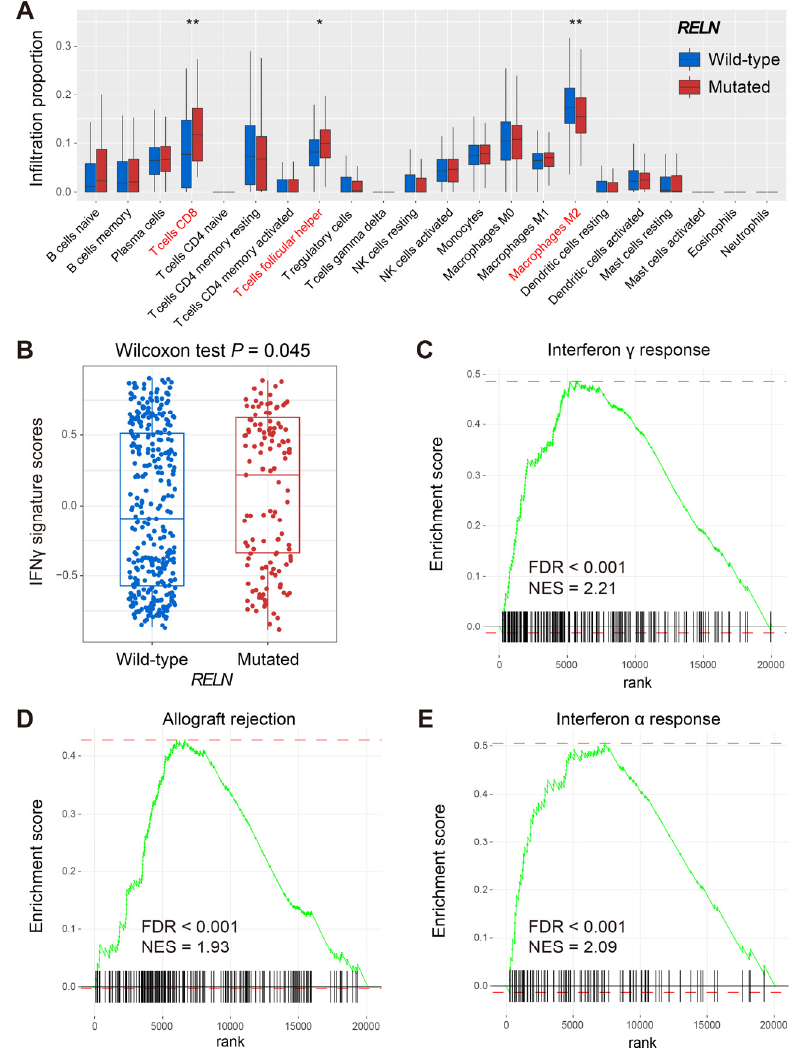
Figure 5. Immune infiltration and signaling pathways behind RELN mutations in melanoma. ( A ) CIBERSORT method revealed the distinct immunocyte infiltration in RELN two subgroups. ( B ) Distinct enrichment scores of IFN γ signature in RELN two subgroups. Immunogenicity-related signaling pathways of ( C ) interferon γ response, ( D ) allograft rejection, and ( E ) interferon α response were enriched in patients with RELN mutations. * p < 0.05, ** p < 0.01.